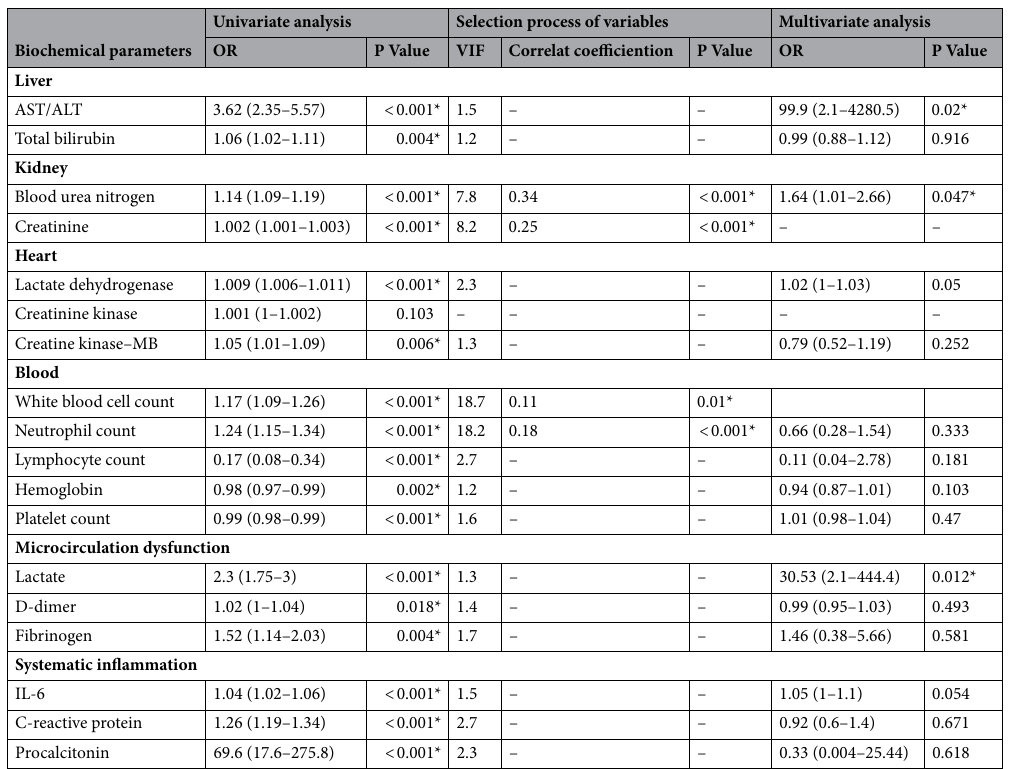
Table 4. Univariate and multivariate analysis on poor prognosis (Death). Patients with clear survival data (recovery and death) were enrolled in the analysis on prognosis (N = 555). # Variance inflation factor (VIF) > 5 was considered collinearity. *A two-tailed P value less than 0.05 was considered statistically significant.